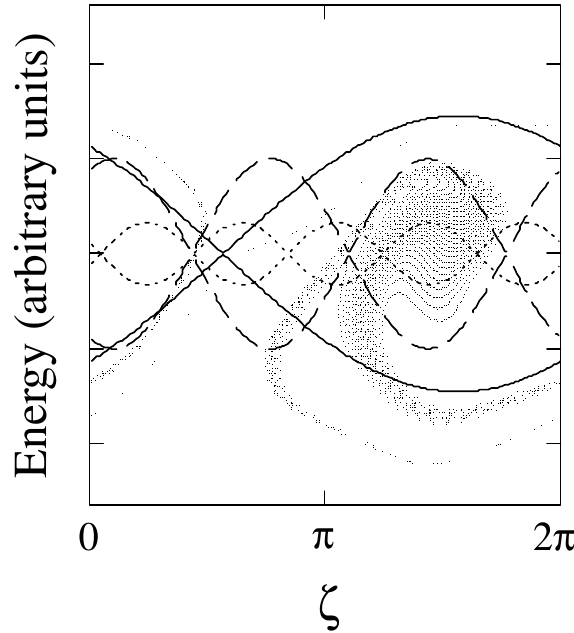
FIG. 11. Longitudinal e -beam phase space (energy phase) in a free-electron laser operating with a biharmonic undulator, at saturation. The separatrices corresponding to the fundamental (continuous line) to the 3rd (dashed line) and to the 5th harmonic fields are